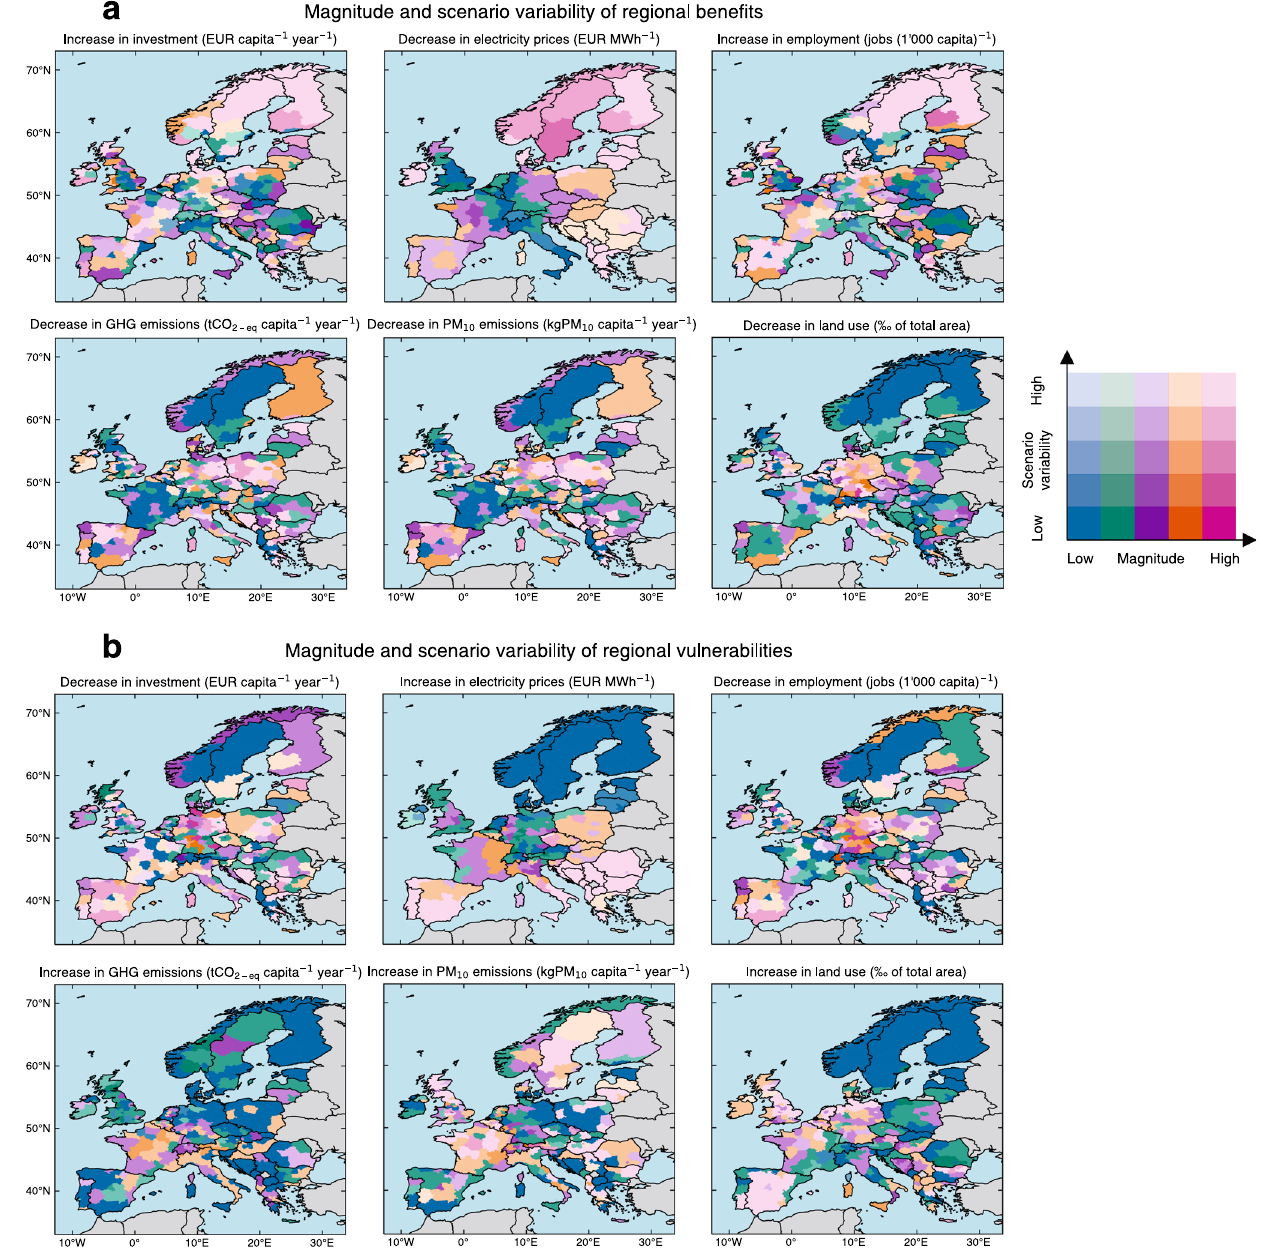
Fig.6|Mapsofmagnitudeandscenariovariabilityofelectricitysectorbene fi ts and vulnerabilities across all scenarios. Magnitude is de fi ned as the average regional bene fi t ( a ) or average regional vulnerability ( b ) across all 248 MGA sce- narios and the minimum cost scenario as compared to the scenario of frozen generation and storage capacities. Scenario variability is de fi ned as the